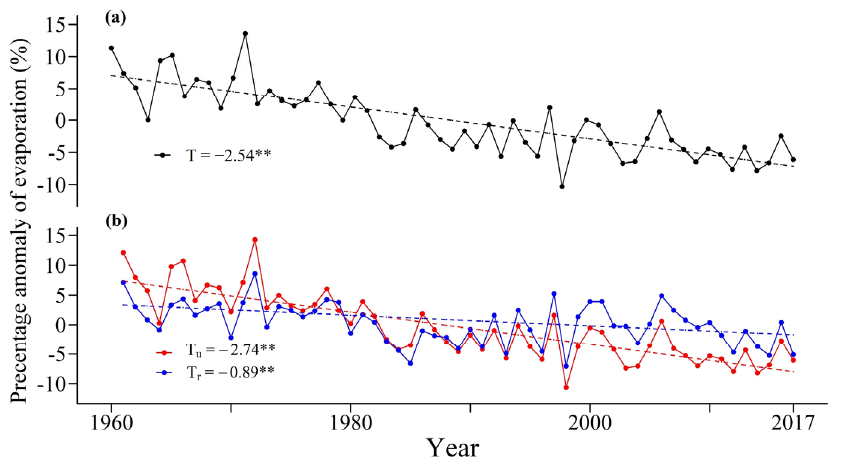
Figure 2. Change trends of the warm season (May to September) mean pan-evaporation for all ( a ), urban and reference stations ( b ) in the whole study region, 1961–2017 (T, Tu, Tr: regional average trend; * and ** refers to the statistically significant trend at 0.05 and 0.01 levels of significance).